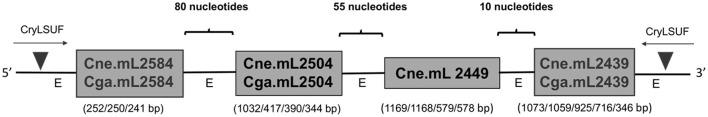
Distribution of group I introns in mitochondrial LSU rRNA of C. neoformans and C. gattii isolates. The scheme shows the order of the introns within the LSU rRNA gene observed after alignment of the sequenced samples. Introns are separated by conserved regions of the mitochondrial genome. Triangles indicate the annealing regions of the CryLSUF and CryLSUR primers flanking all the introns. The different sizes for each intron as well as the exon (“E”) regions are shown in the figure.